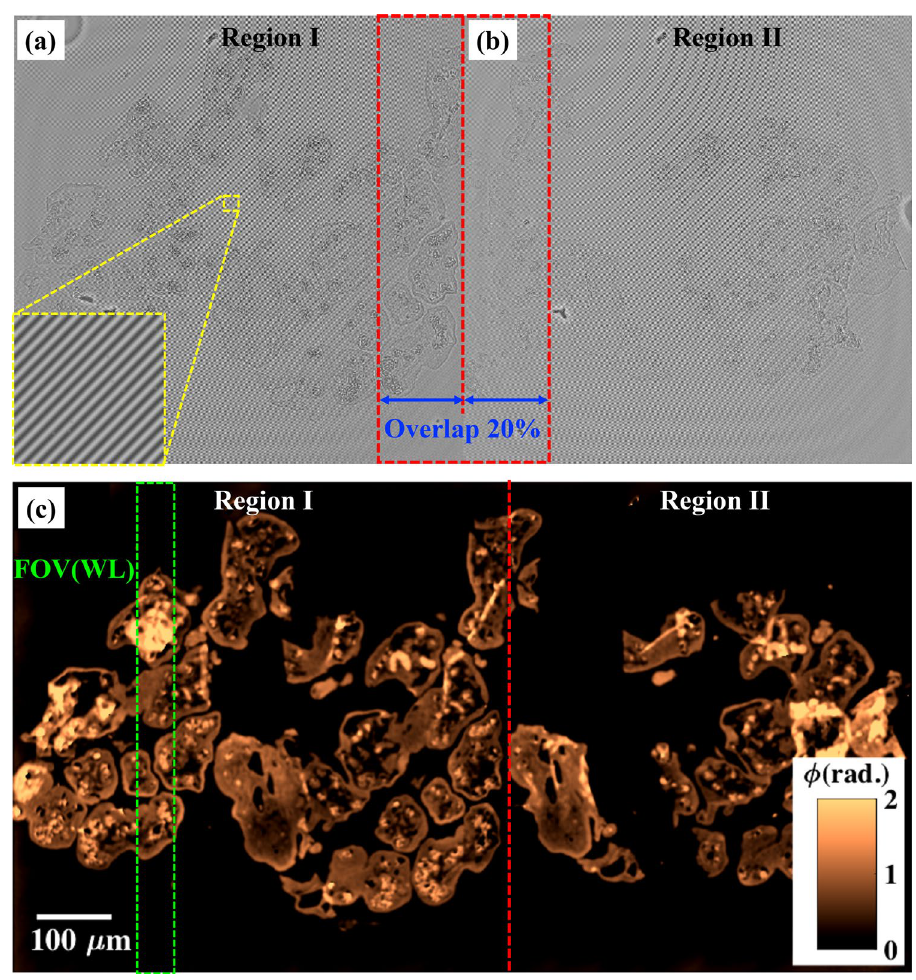
Figure 7. Large FOV phase imaging. ( a , b ) Interferometric images of the placenta tissue sample. The inset depicts the zoomed view of a small region of the interferogram marked with yellow dotted box. ( c ) Stitched phase image of the whole tissue sample of 1 μm thickness. The color bar is in